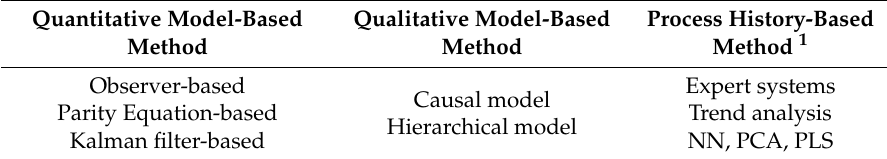
Table 2. Classification of model-based FDD